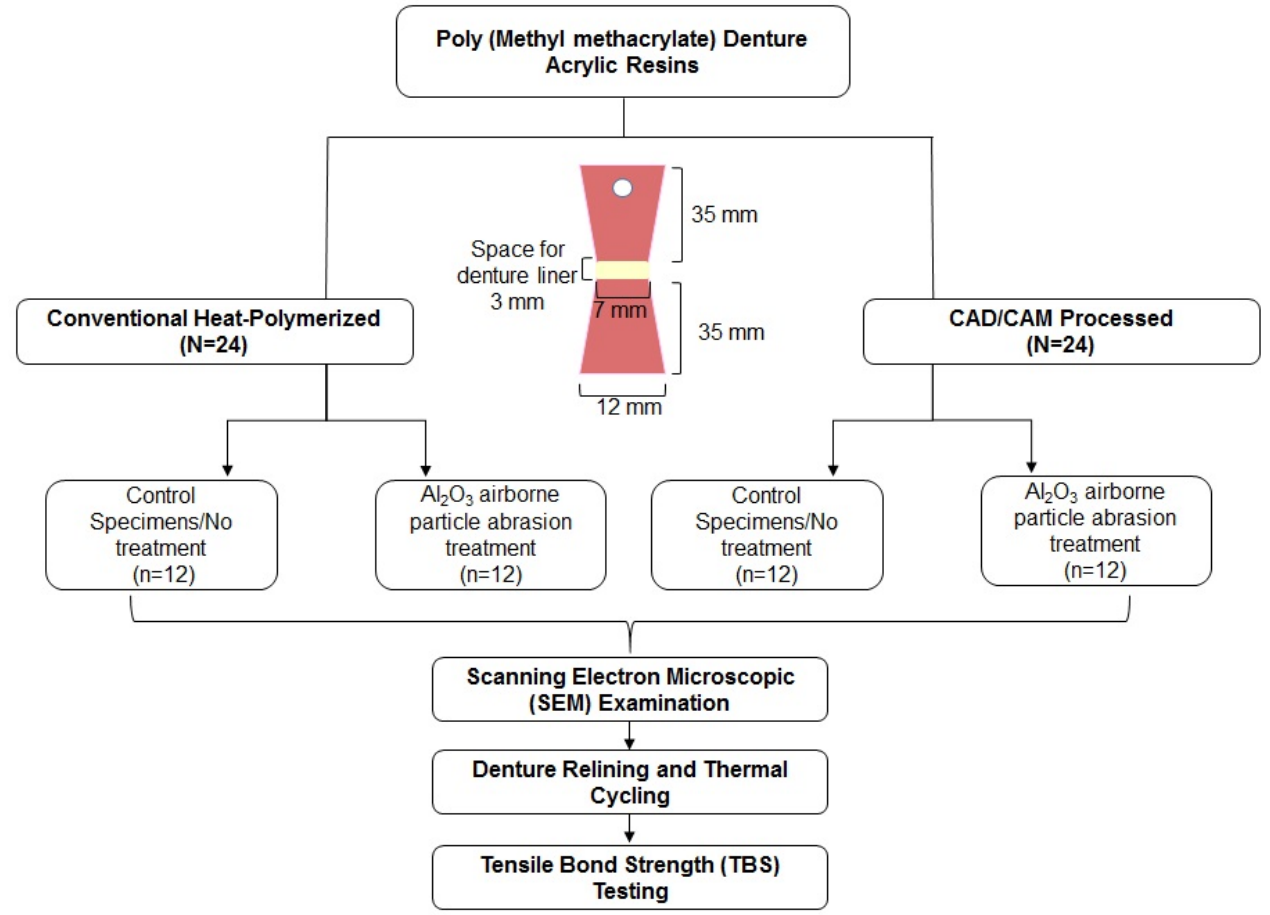
Figure 1. Specimen distribution and study procedure .